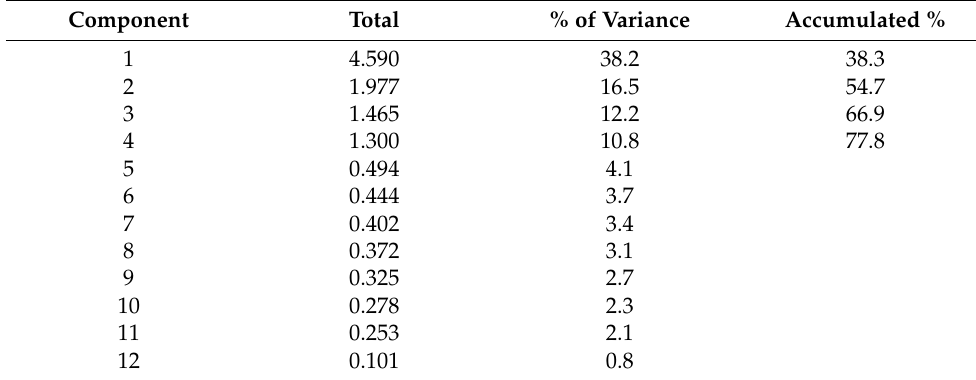
Table 3. Total explained variance.